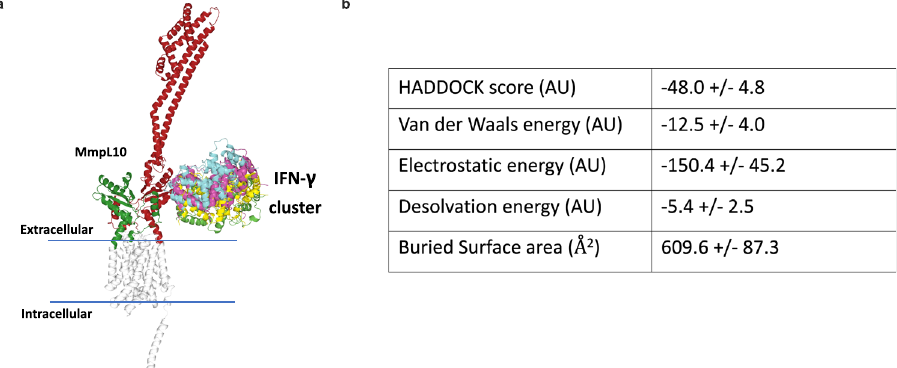
Fig. 4 A structural model indicating a putative binding pose for IFN- γ on MmpL10. The fi rst and second extracellular regions of MmpL10 are colored green and red, respectively ( a ). The cluster of potential IFN- γ conformations can be seen contacting the membrane proximal region of the second MmpL10 extracellular region. Scoring metrics were obtained from unguided docking experiments probing the MmpL10-IFN- γ docking cluster generated by HADDOCK, demonstrating reduced energy indicating an interaction ( b